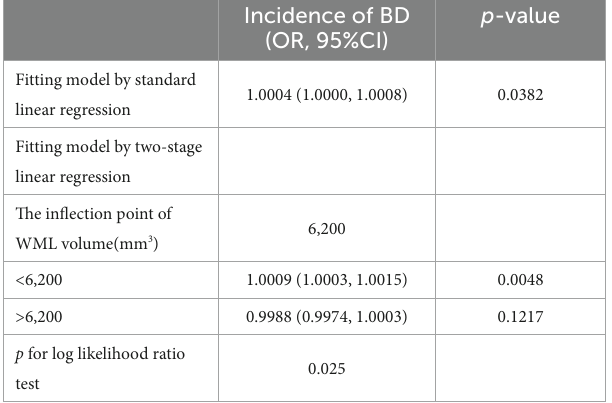
TABLE 2 Results of two-piecewise linear regression model. Incidence of BD (OR, 95%CI)